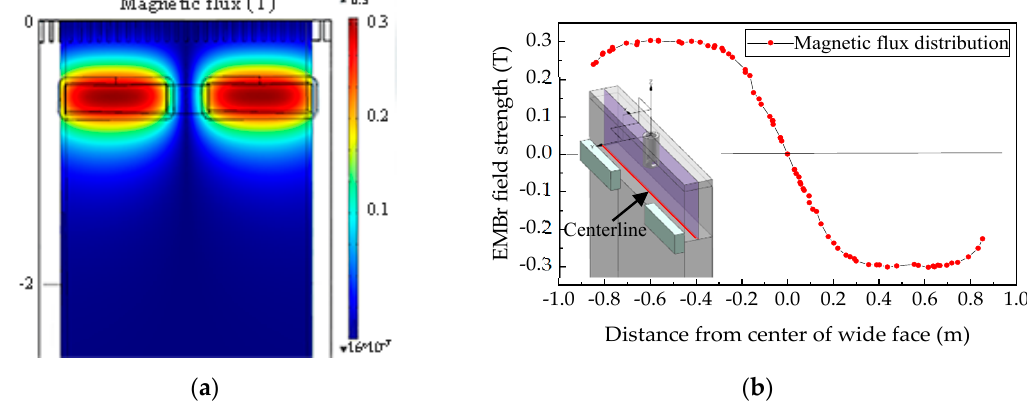
Figure 3. Electromagnetic braking (EMBr) field strength profiles for setting 0.3 T in the slab mold. ( a ) Magnetic flux distribution in the longitudinal section; ( b ) Magnetic field strength profiles along a wide-face centerline.